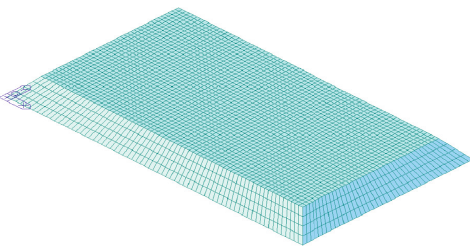
Figure 5: Tower base model